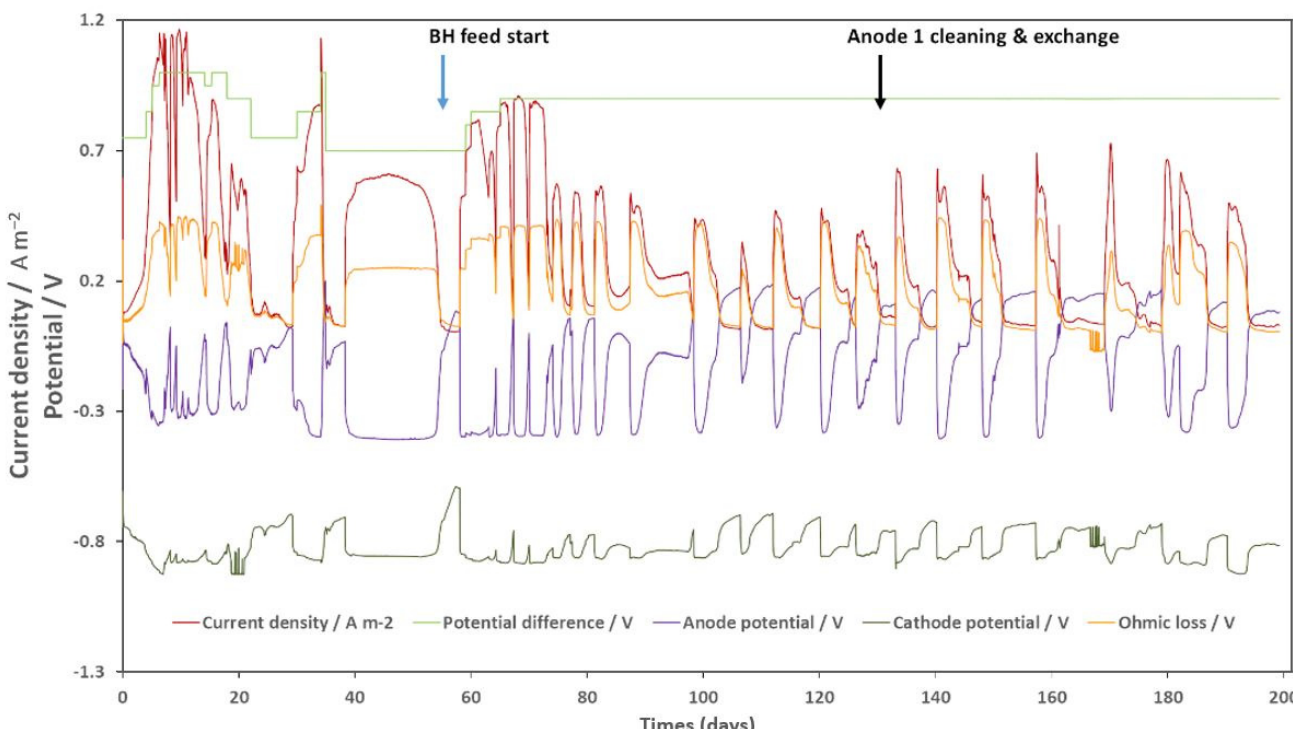
Figure 8. Performance of the bioanode regeneration experience. The y -axis on the left indicates the current density and the potential. Anode and cathode potential versus Ag/AgCl electrodes were presented.